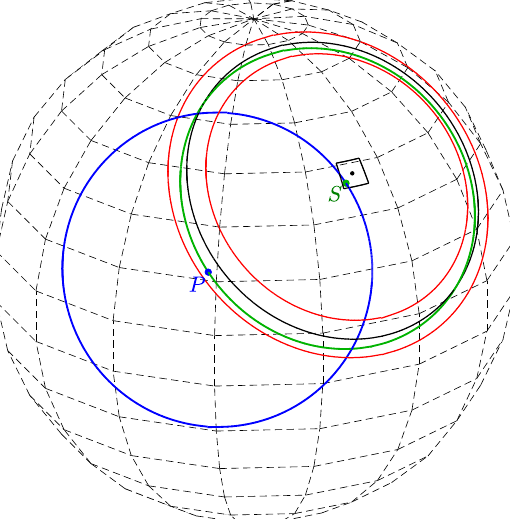
Figure 14. The primary point P (blue) with the corresponding primary circle (blue), which votes for the cell with the maximum count. The secondary point S on the primary circle and inside the cell defines a secondary circle (green) passing exactly through the primary point P . The primary point P is located within a spherical segment associated with the cell. The black circle is the common secondary circle defined by the center of the cell, and the red circles are the lower and higher critical circles.